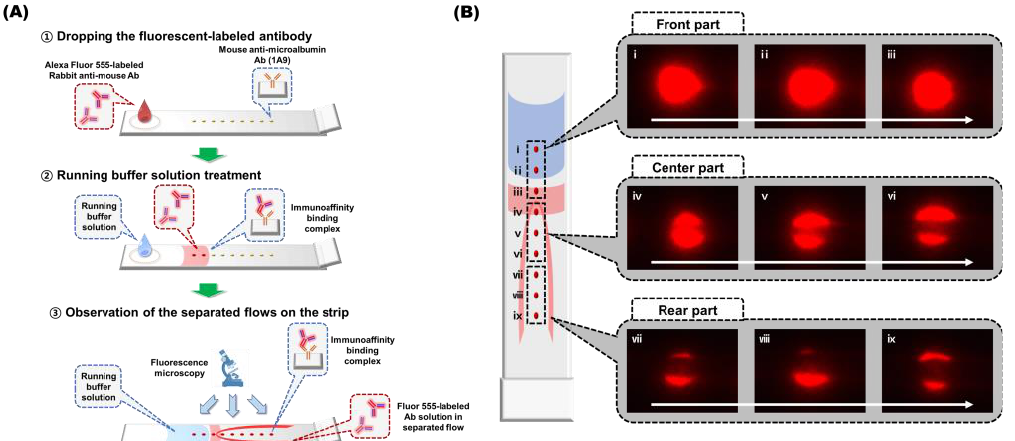
Figure 3. Schematic illustration of the flow observation procedure and resulting images of the flow around the developed spot. ( A ) Schematic illustration of the flow observation procedure. ( B ) Fluorescence images of the developed spots. The white arrow indicates the flow direction in the LFI.